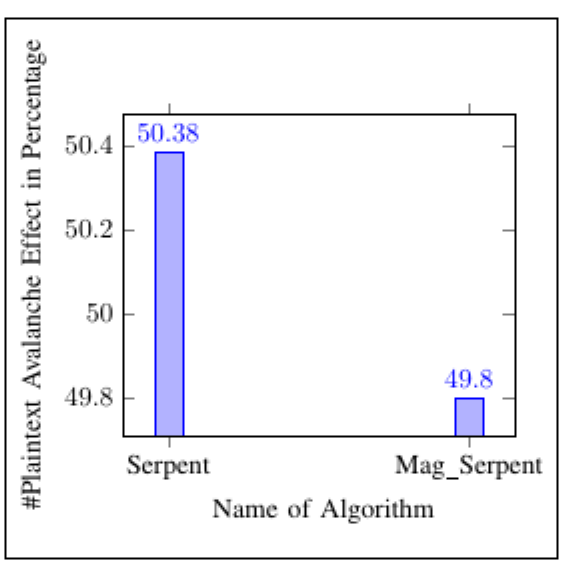
Figure 13. Experimental key Avalanche Effect in percentage.